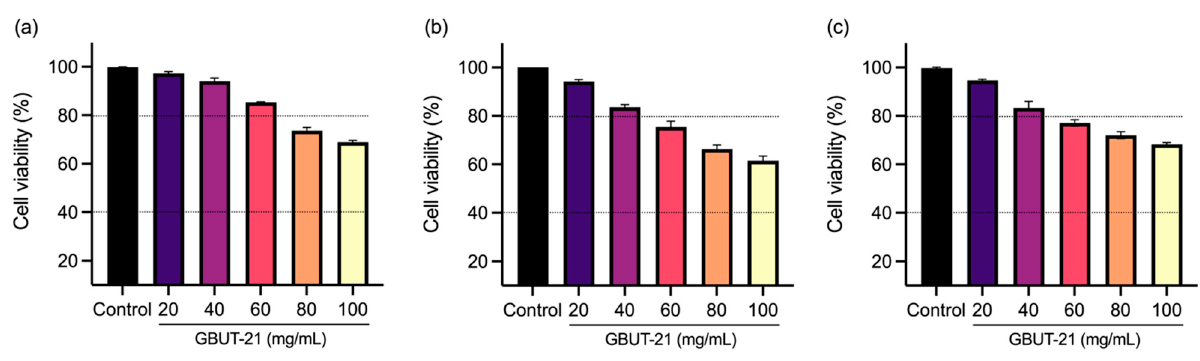
Figure 2. The therapeutic concentration of GBUT11 CSF is well-tolerated by human cell lines. MTT assay was performed on HeLa, HEK, and HCE cell lines to check the percentage viability in the presence of the sample. Cells were seeded in 96-well plates at a density of 4 × 10 5 and treated with the sample for 24 h. Percentage viability: ( a ) HEK, ( b ) HeLa, and ( c ) HCE cells at different concentrations of the